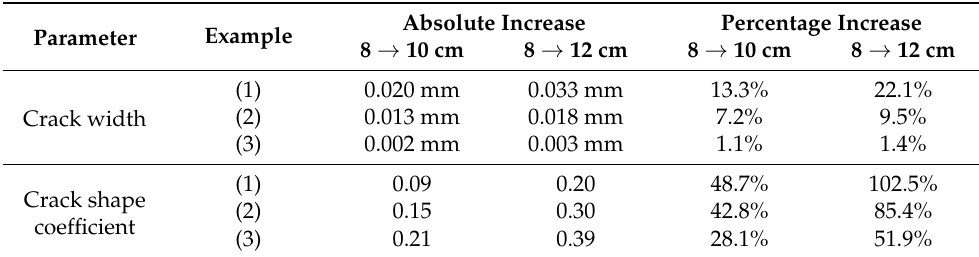
Table 5. The changes in crack widths and crack shape coefficients depending on the change in the assumed effective length (see Figure 26).